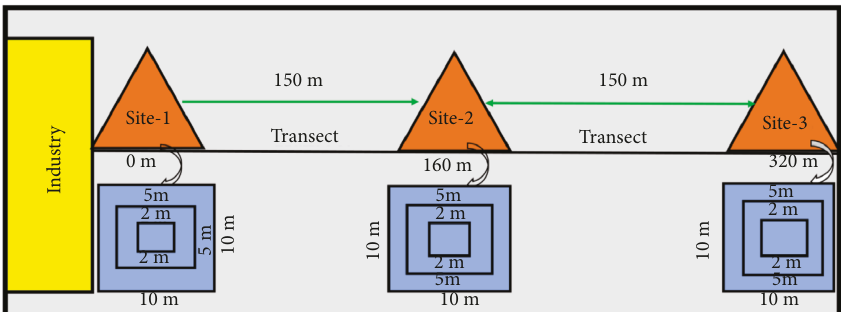
Figure 2: Diagram of sampling design of the study area of the Bhawal Sal forest (source: the